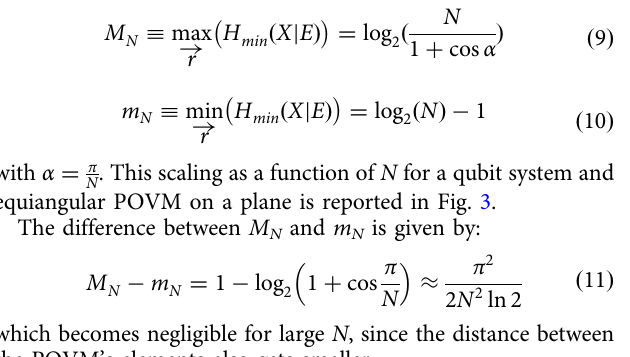
Fig. 3 Min-entropy scaling as a function of the number of POVM elements. Scaling of H min ( X ∣ E ) as a function of N . In the untrusted scenario, we report the max and the min H min ( X ∣ E ) for N equispaced POVM on a plane of the Bloch sphere. We also report the max H min ( X ∣ E ) for POVM representing platonic solids inscribed in the Bloch sphere. The dashed line represents the upper-bound for the trusted model. Finally, the colored dot represent estimated min-entropy from the experimental data. The error bars represent the standard deviation of the mean but they are smaller than the symbols of the